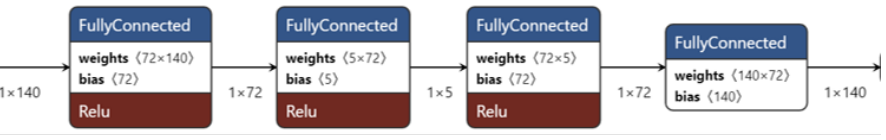
Figure 5. Simple Autoencoder